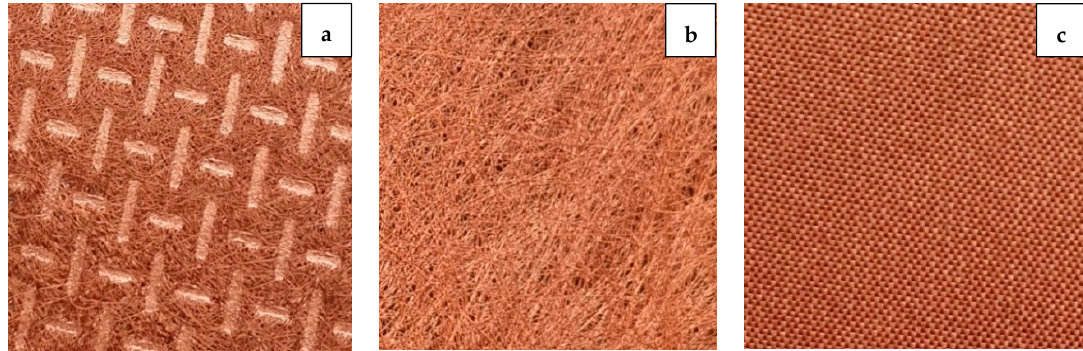
Figure 3. Cloth construction of ( a ) Shieldex ® Kiel-SK-96, ( b ) Shieldex ® Koln, and ( c ) Shieldex ® Prag conductive fabrics.